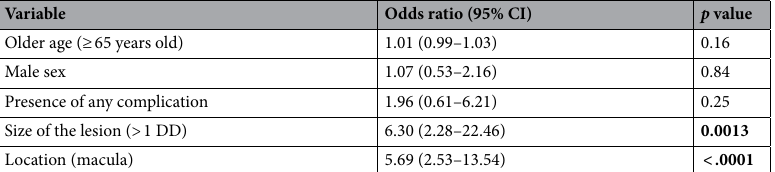
Table 5. Multivariate binary logistic regression of variables associated with poor visual prognosis in eyes with inactive ocular toxoplasmosis at presentation (final best-corrected visual acuity ≤ 20/200; n = 178 eyes). DD = disc-diameter; CI = confidence interval.